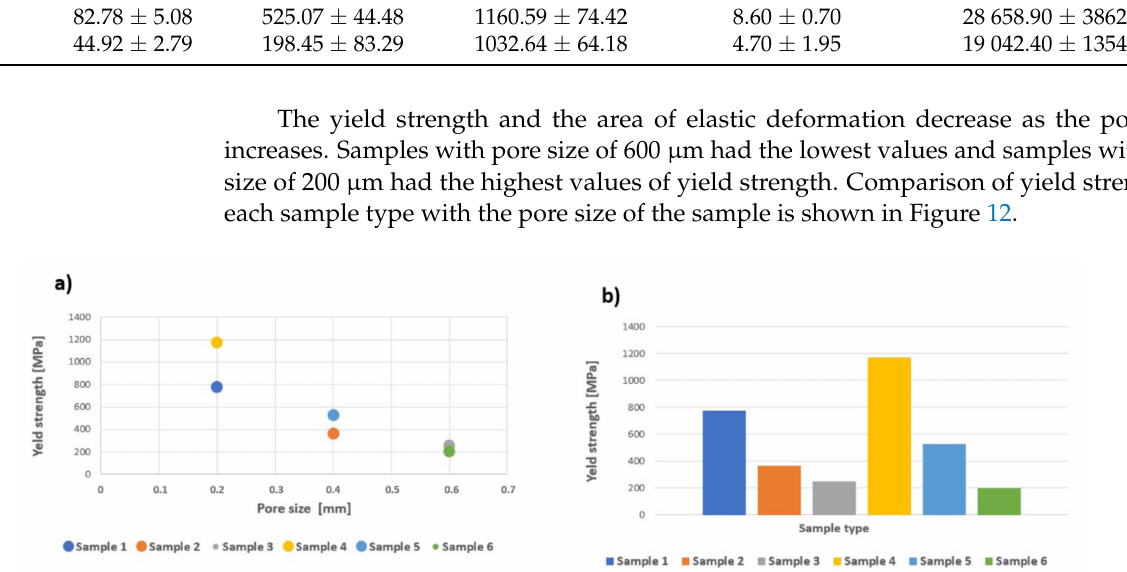
Figure 12. ( a ) Comparison of yield strength of 6 types of samples considering the pore size ( b ) Average values of yield strength for individual types of